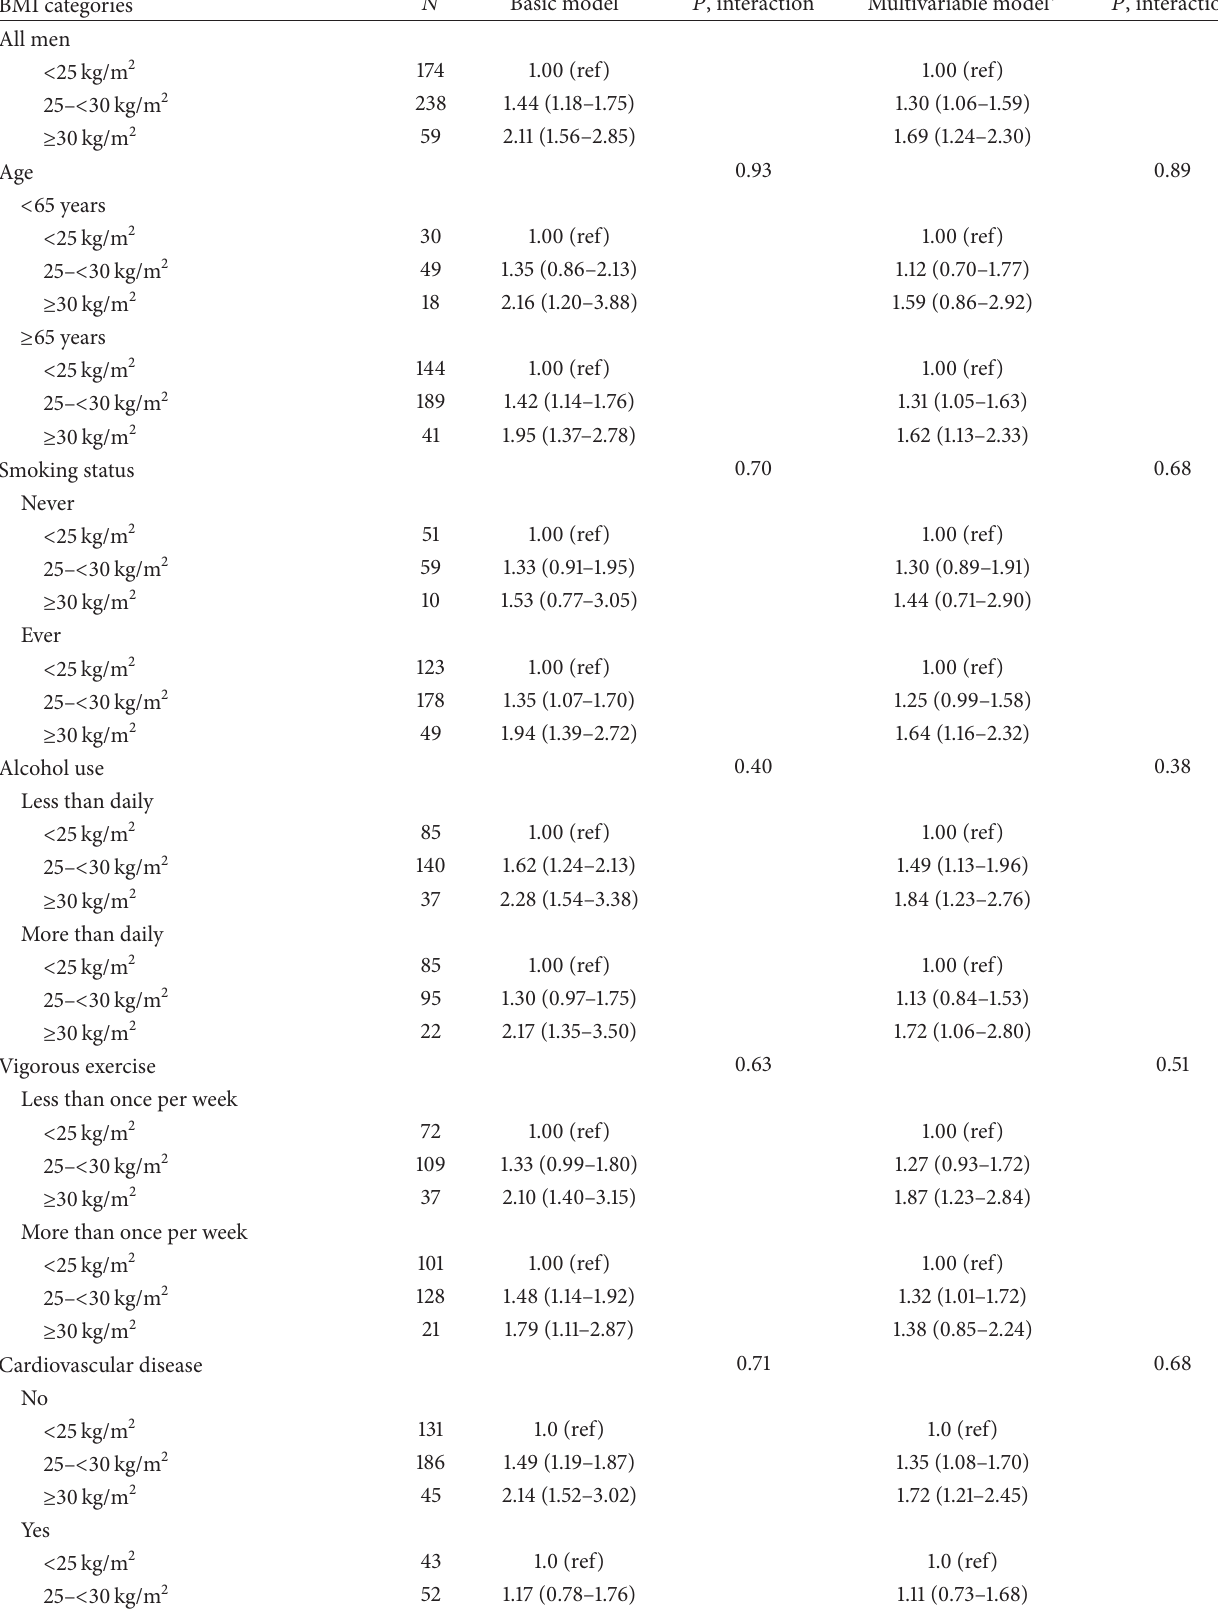
Table 2: Hazard ratio of clinically diagnosed AAA in association with baseline body mass index (BMI) overall and in